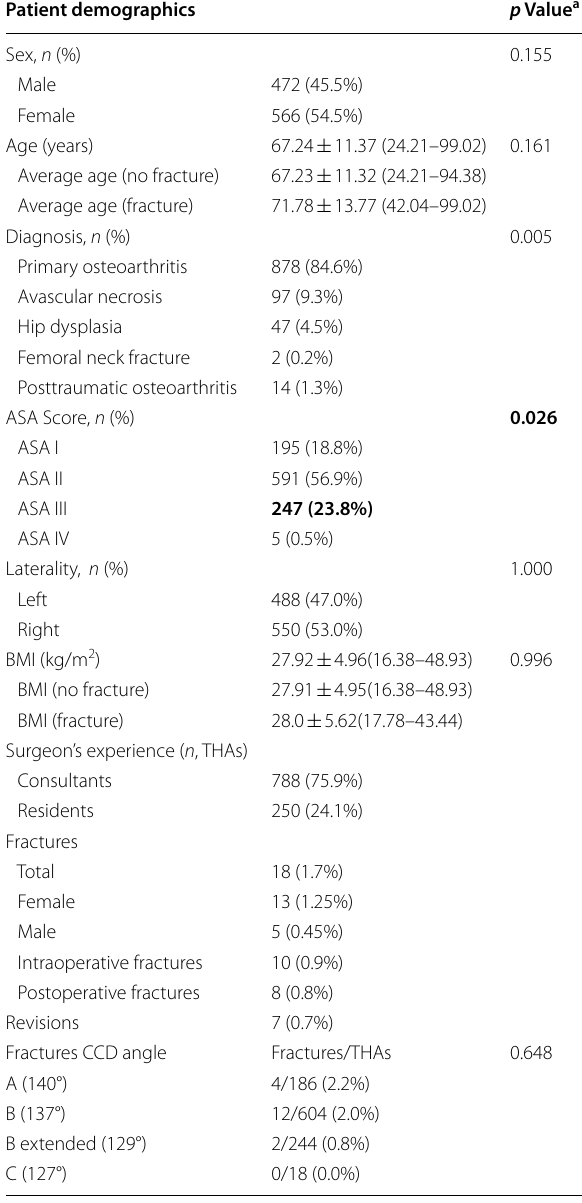
a Testing patients with fracture versus patients without